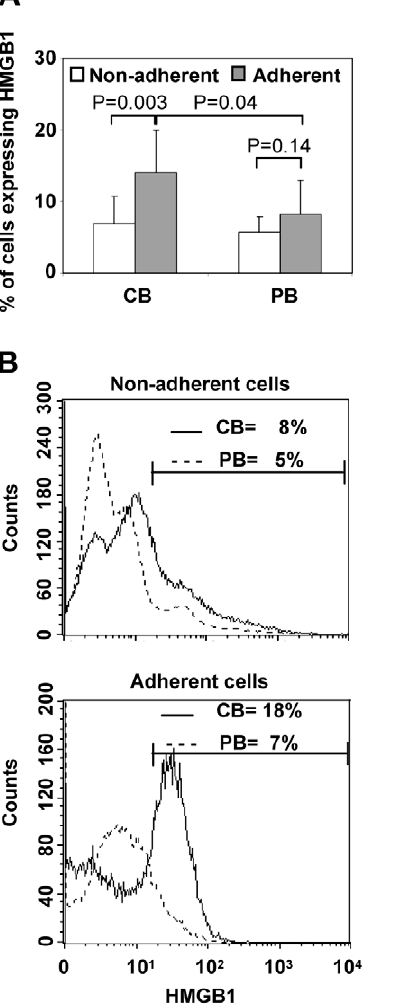
Figure 3. HMGB1 is present mostly in CB adherent cells. Mononuclear cells isolated from human CB and PB have been cultured in complete growth medium. After 14 days, two cell populations have been identified: adherent and non-adherent cells. (A) The cell surface expression of HMGB1 was determined in the two cell populations by flow cytometry analysis. Data are shown as percentage of cells expressing HMGB1 and values are mean 6 SD of eight experiments from different donors. Statistical analysis compared non-adherent versus adherent cells or CB versus PB (*P , 0.05, **P , 0.01 paired Student’s t test). (B) The fluorescence histogram plots displays HMGB1 levels in non-adherent and adherent CB (solid line) and PB cells (dotted line) and the percentage of HMGB1 positive cells is indicted in graphs. Data reported is representative of eight different experiments.